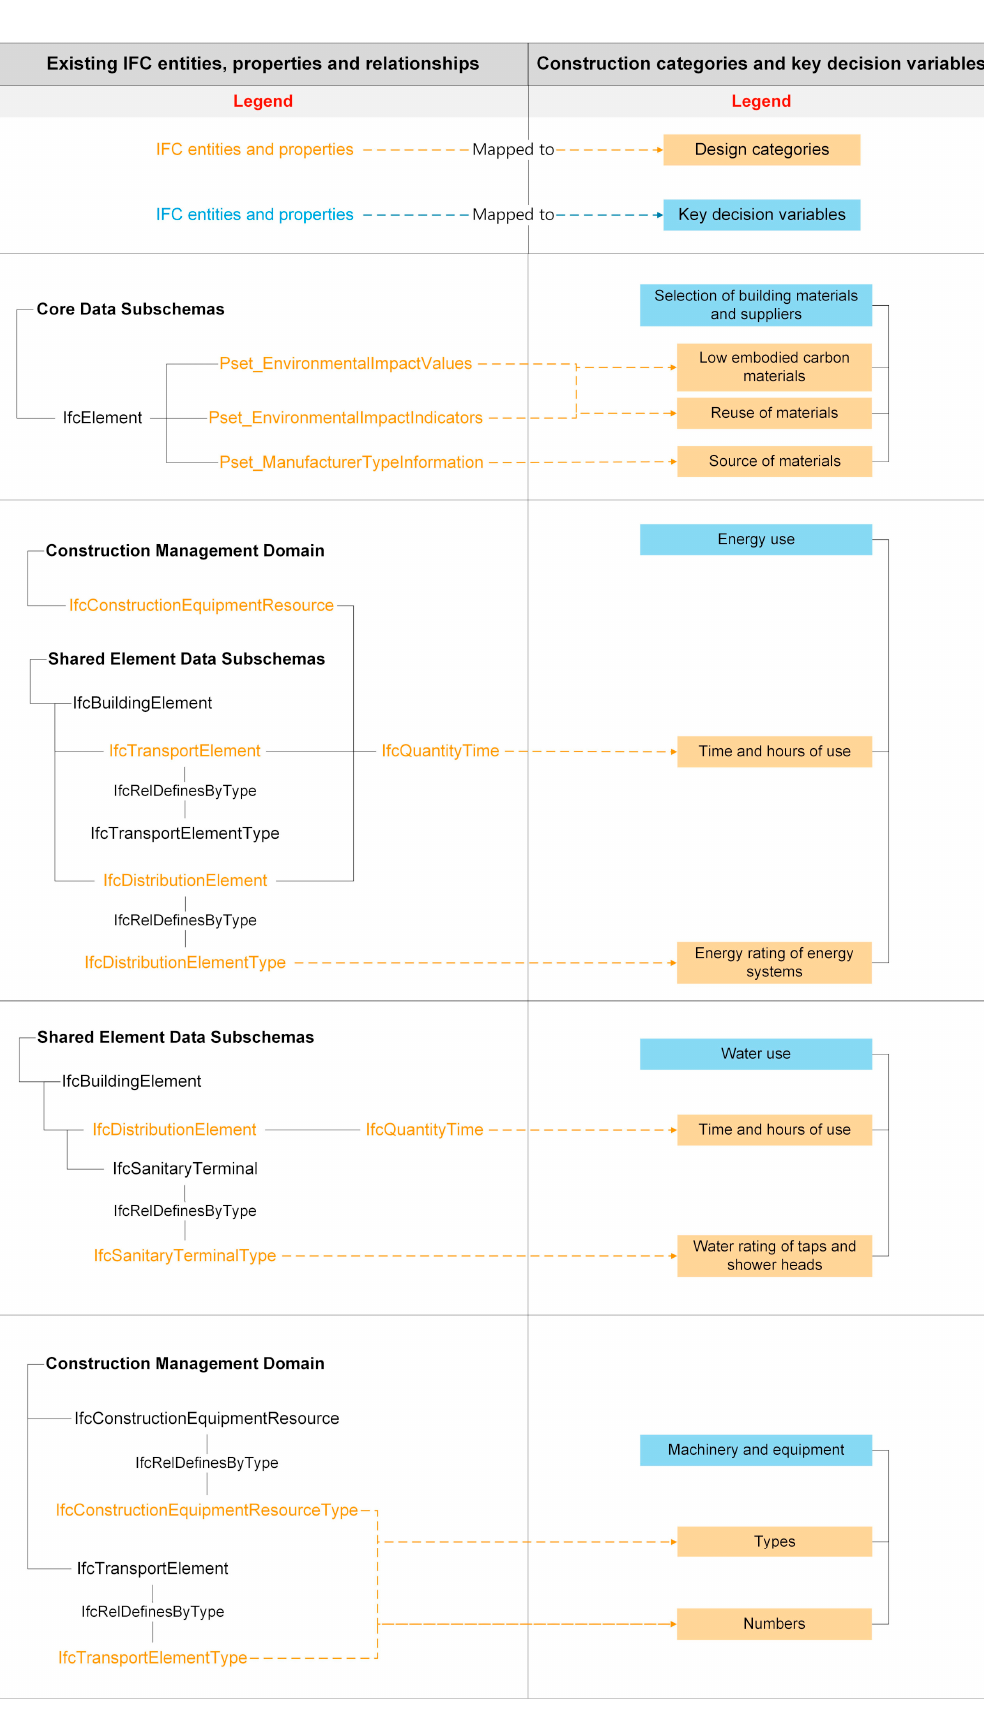
Figure 10. Existing IFC entities, properties, and relationships representing construction categories and key decision variables affecting net-zero-carbon building outcomes at construction stage.